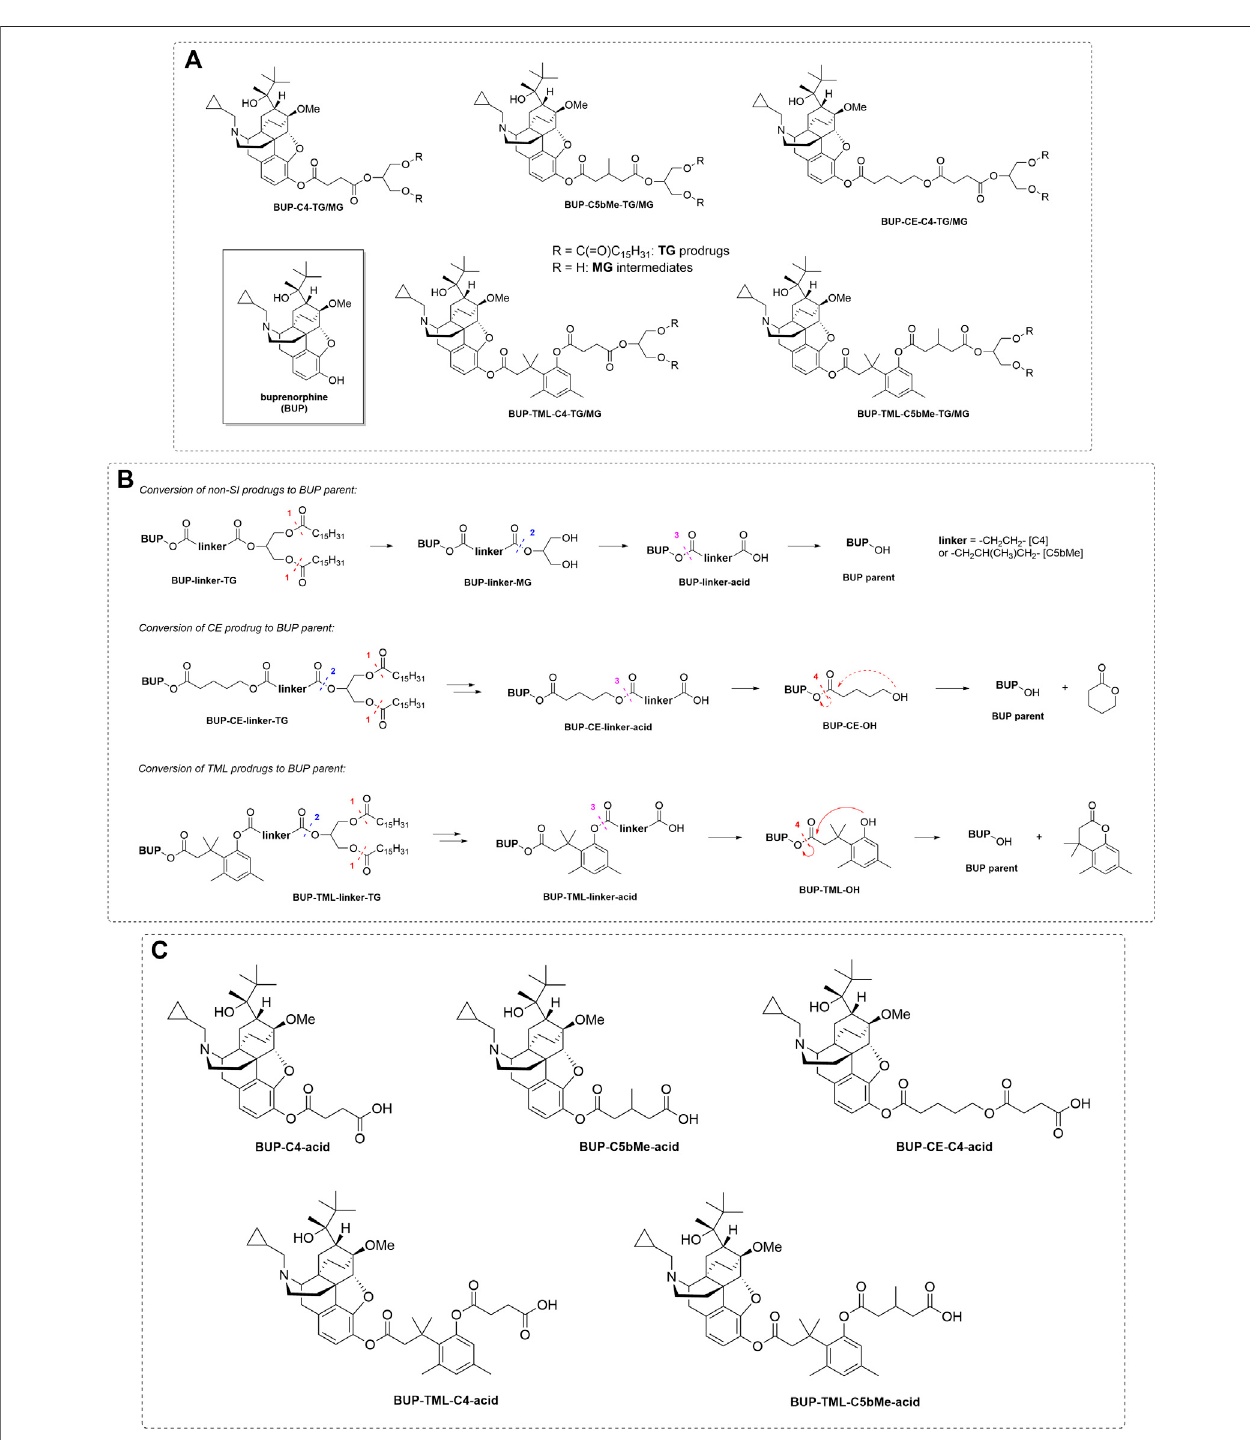
FIGURE 1 | Panel (A) Structure of BUP, TG prodrugs and MG forms of the prodrugs (i.e., the lipolysis products after the removal of the fatty acids in the sn-1 and sn-3 positions from the prodrugs). Panel (B) General schematic to show the proposed mechanisms of release of drug from prodrug in plasma for both SI and non-SI containing prodrugs. The dashed lines and arrows indicate the expected mechanisms for BUP release from the MG or acid forms of the prodrugs and the numbers indicate the expected order of transition. Panel (C) Structures of the acid forms of the prodrugs (i.e., the intermediate products after cleavage from the MG in plasma and before breakdown of the acid form to generate